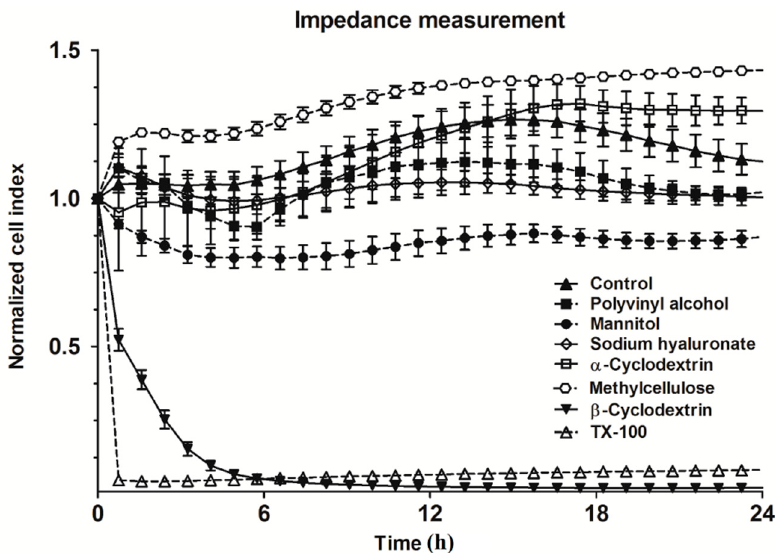
Figure 2. Changes in cell index indicating viability of RPMI 2650 cells treated with different excipients for 24 h and measured by real-time cell impedance analysis. All values presented are means ± SD, n = 8. TX-100: 1% Triton X-100.